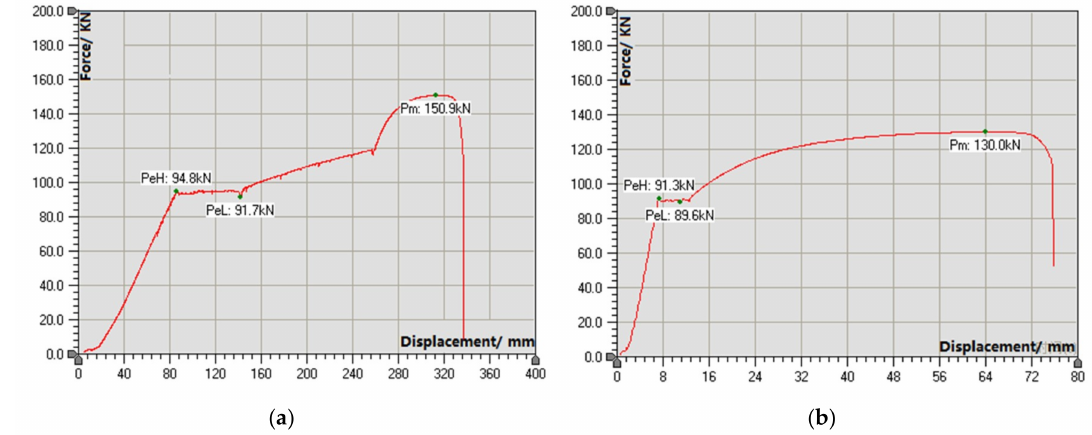
Figure 9. Force-displacement curves of the left-hand and right-hand threaded steel bolts with the diameter of Φ 18. ( a ) Left-hand threaded steel bolts; ( b ) right-hand threaded steel